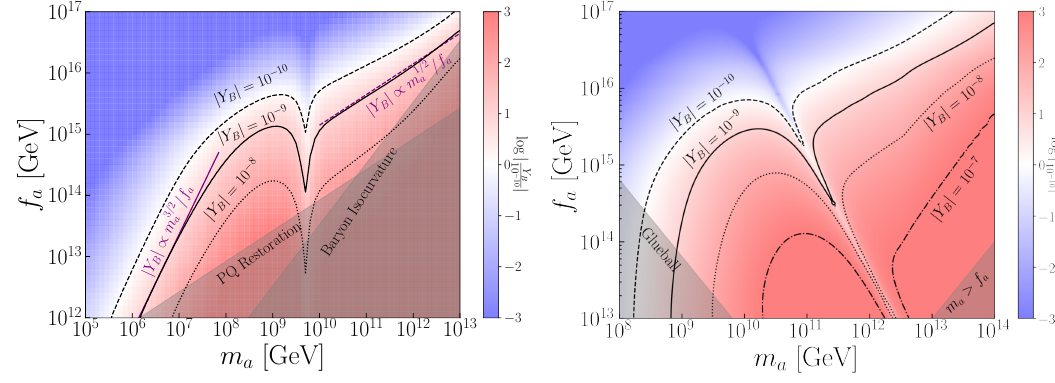
Figure 2 . The primordial baryon asymmetry Y B generated from spontaneous baryogenesis due to heavy axion oscillations for axions coupled to a confining dark sector. (Left) We assume that the heavy axion mass m a is temperature-independent. (Right) We assume that mass is temperature dependent for an SU(3) dark sector that has the same temperature as the SM. In this figure we assume c aG = c af = 1 , though Y B scales linearly with the couplings. Red regions overproduce the baryon asymmetry while blue regions underproduce it. The overproduction regions are still important because they can allow for extra entropy dilution at late times, which is the case when we include an additional, lighter axion that explains the DM. Note that the dips in the contours arise from an accidental cancellation in the lepton asymmetries generated between the axion-gauge couplings and the axion-matter couplings in (4.3); this cancellation would generically not occur for non-universal couplings, as illustrated in appendix C. Note that in the right panel we chose c 6 = 1 and Λ = 10 13 GeV — parameters which control the glueball decay — for